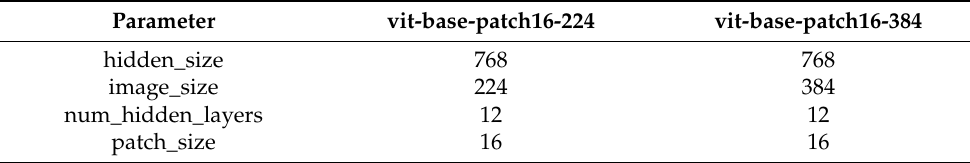
The parameters in Table 1 have the following meaning: